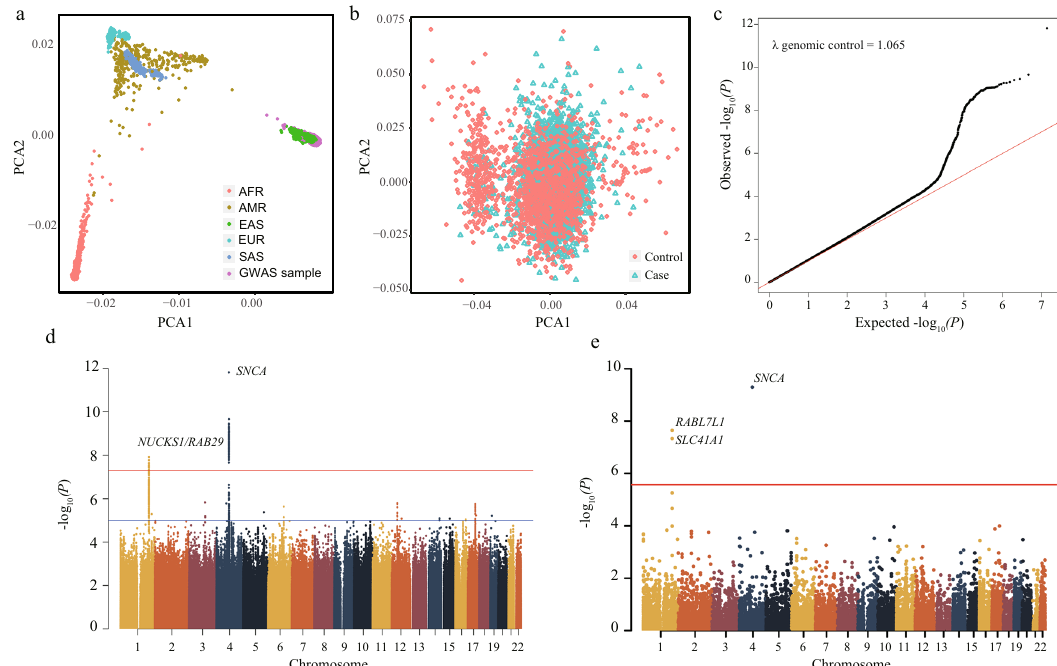
Fig. 2 Association results of GWAS cohort. a PCA plot of samples projecting to the 1000 Genomes subjects. b PCA of our 1972 PD cases and 2478 controls in GWAS cohort. c The quantile – quantile (Q – Q) plot of the association results from the GWAS cohort. d Manhattan plot of P values on the − log 10 scale for 6,910,086 SNPs in the GWAS cohort. e Manhattan plot of P values on the − log 10 scale for genome-wide gene- based analysis in the GWAS